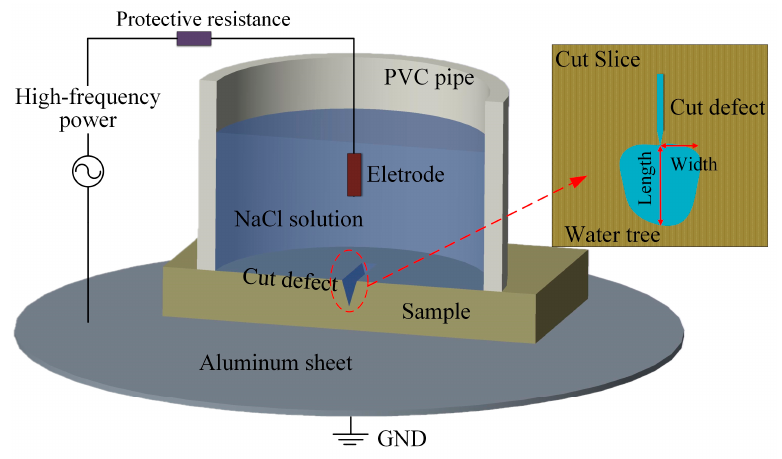
Figure 2. Schematic water-tree aging experiment with water-knife electrode method.